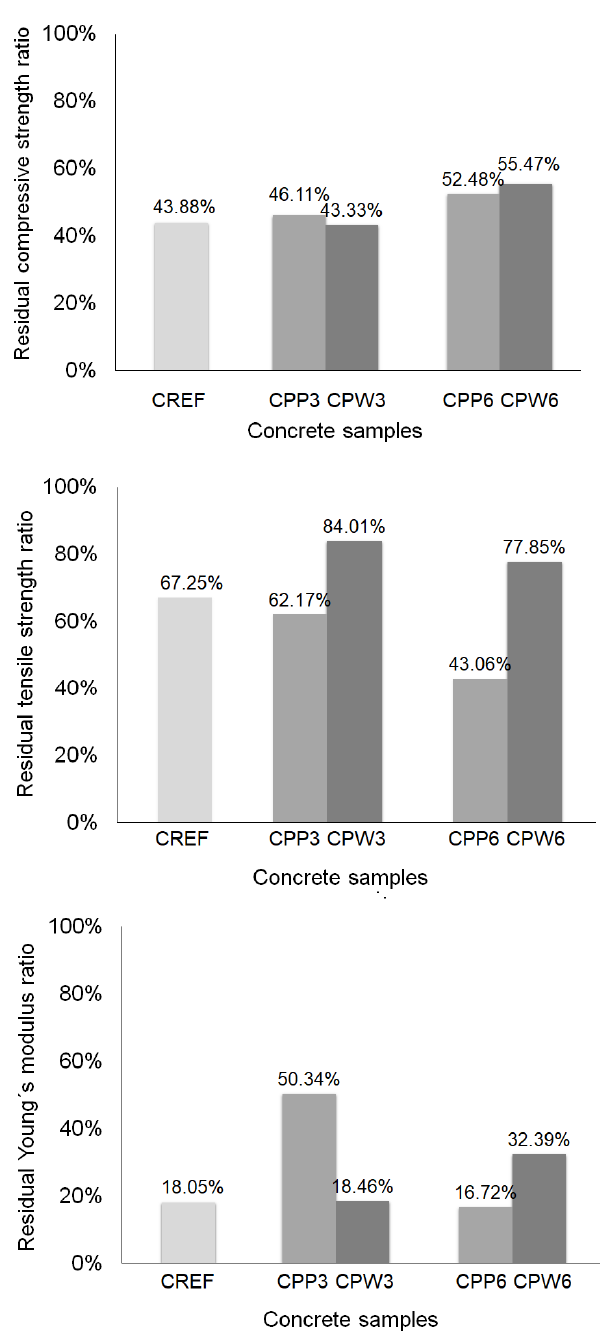
Figure 11. Residual mechanical properties.